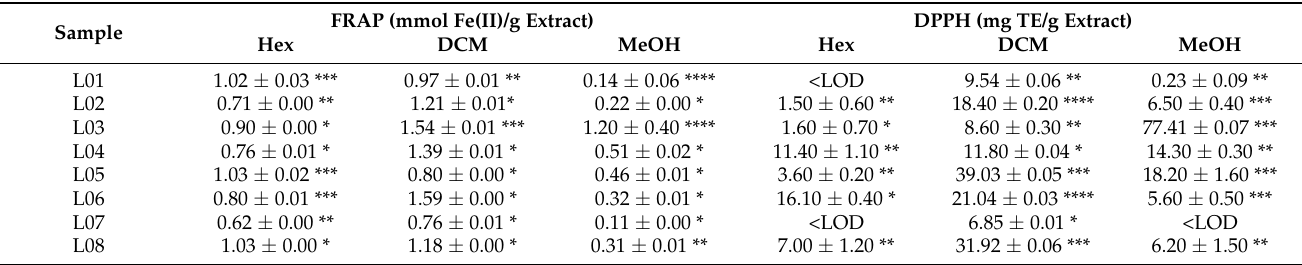
Table 4. Outcome of DPPH (2,2-DiPhenyl-1-PicrylHydrazyl) and FRAP (Ferric Reducing